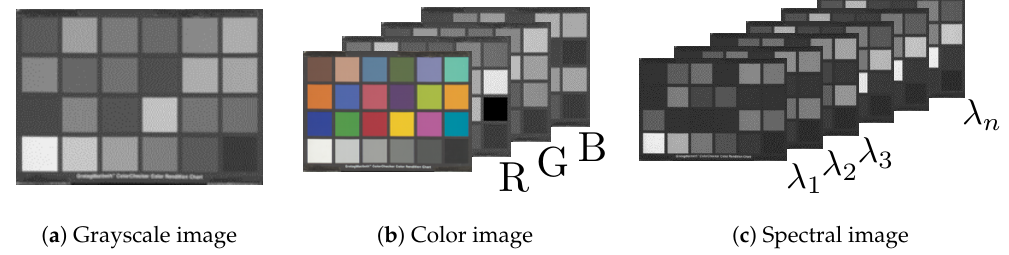
Figure 1. ( a ) A single-channel grayscale image, ( b ) Red/Green/Blue (RGB) color image and its Red/Green/Blue channels as grayscale images, ( c ) spectral image consisting of several bands as a stack of grayscale